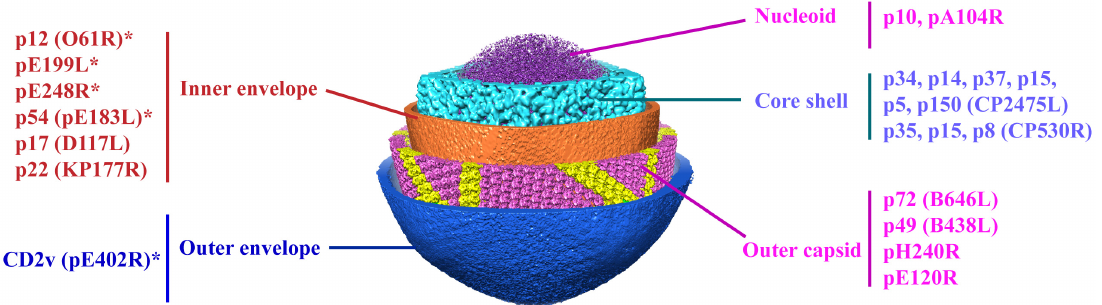
Figure 1. The subviral localization of viral proteins among the five-layered structure of the ASFV particle. The viral proteins involved in virus entry are mainly localized in the layers of the inner envelope, capsid, and outer envelope of ASFV. * Viral proteins involved in ASFV